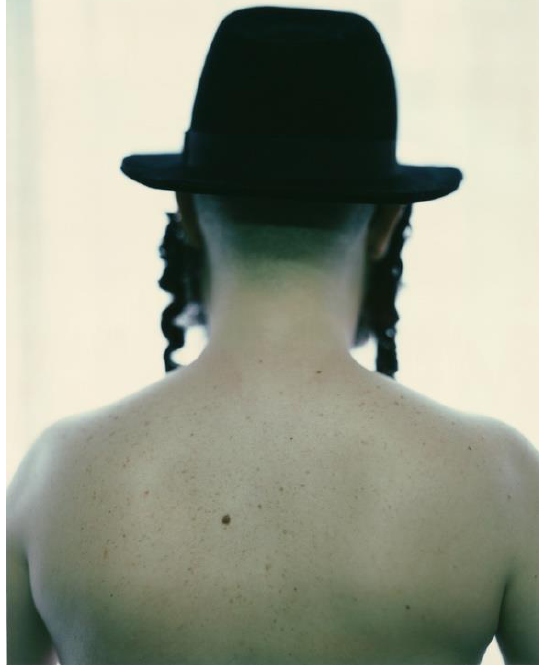
Figure 6 . Oreet Ashery, Self Portrait as Marcus Fisher IV , 2000, original 25.4 × 20 cm; Polaroid scanned to lambda prints, 100 × 110 cm. Photograph by Manuel Vason. Courtesy of the artist.